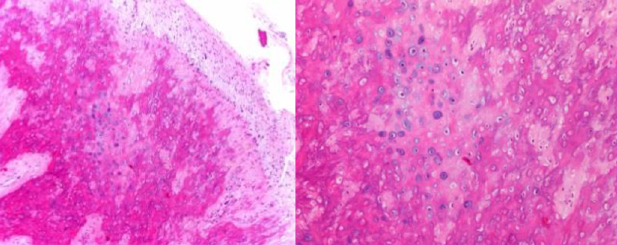
Fig. 5. Section of the upper part of the lesion showing chondroid free fl ap from the right fi bula. Following this second intervention, a second chemotherapy was implemented with adriamycin (Doxorubicine ® ) and cisplatin (Cisplatin ® ). The end-of-treatment assessments have not indicated any